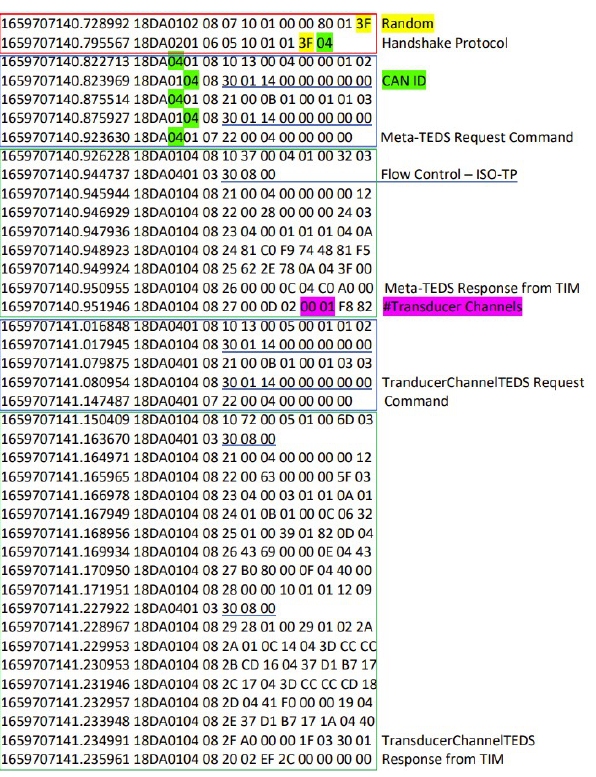
Figure A1. CAN Messages Sequence Between TIM and NCAP.